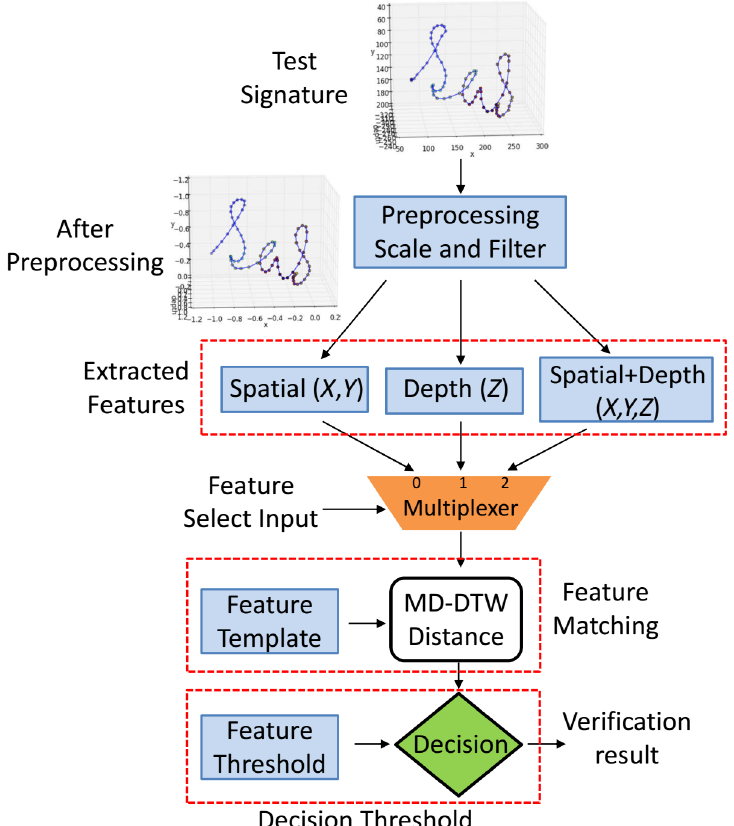
Figure 5. The flow diagram of the testing phase of our in-air signature verification system. The test signature is preprocessed for normalization and smoothing. The extracted features include spatial, depth, and spatial plus depth. Then, a multiplexer with a control input is used to select one of the extracted features. The selected feature is matched with the corresponding feature template using the MD-DTW algorithm. Finally, the verification result is produced by the decision